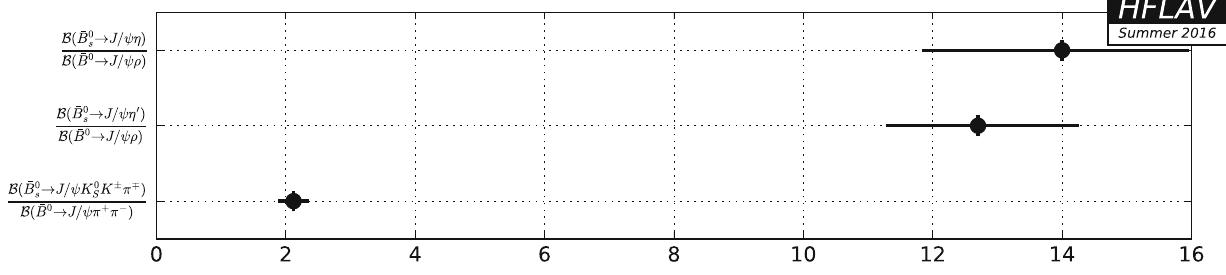
Fig. 163 Summary of the averages from Table 197